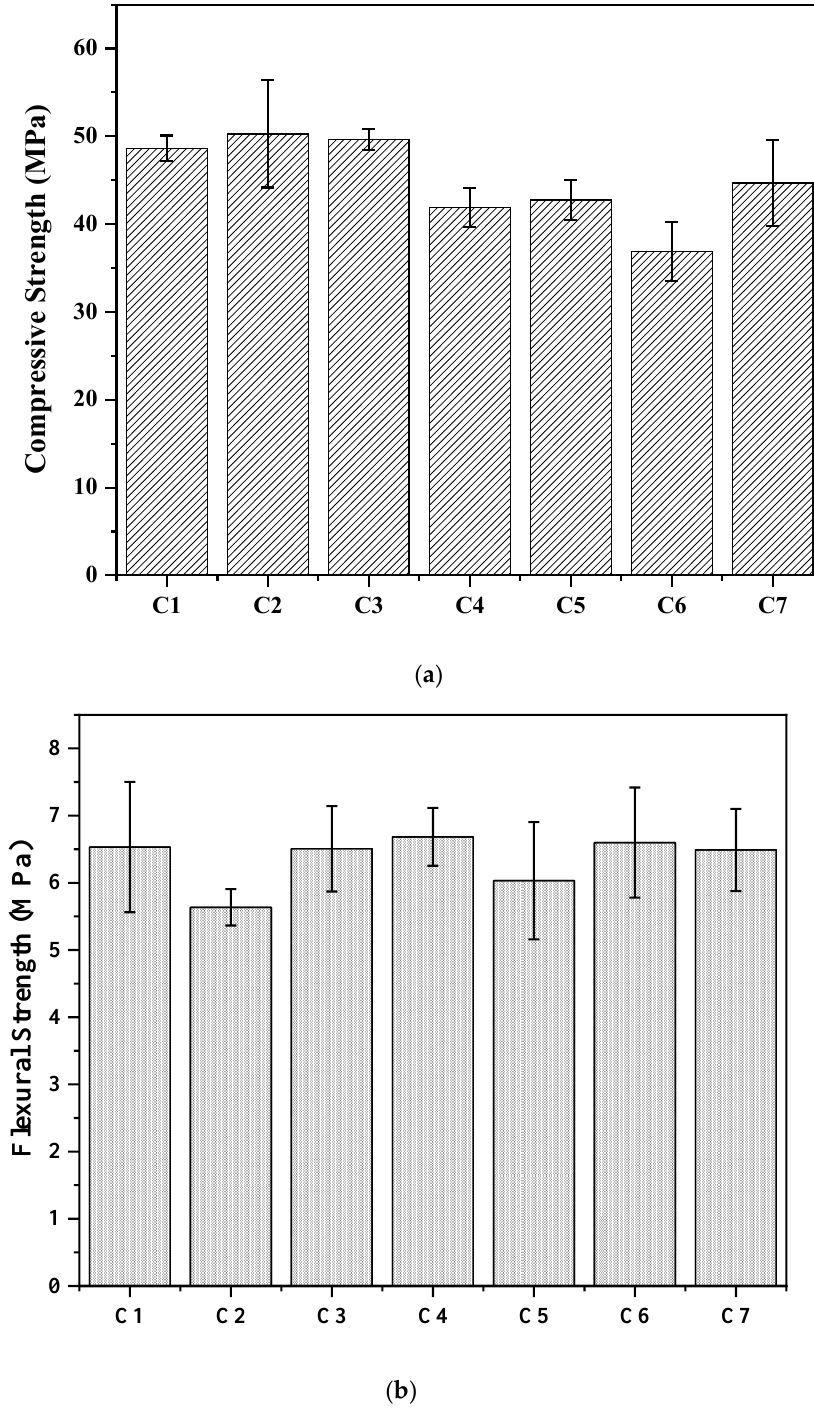
Figure 4. Mechanical results: ( a ) compressive and ( b ) flexural strength.